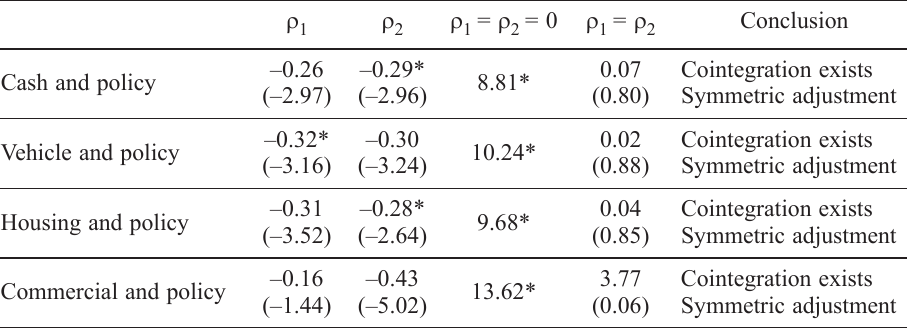
Table 6. Tests of cointegration and symmetric adjustment according to MTAR model ( τ = 0)